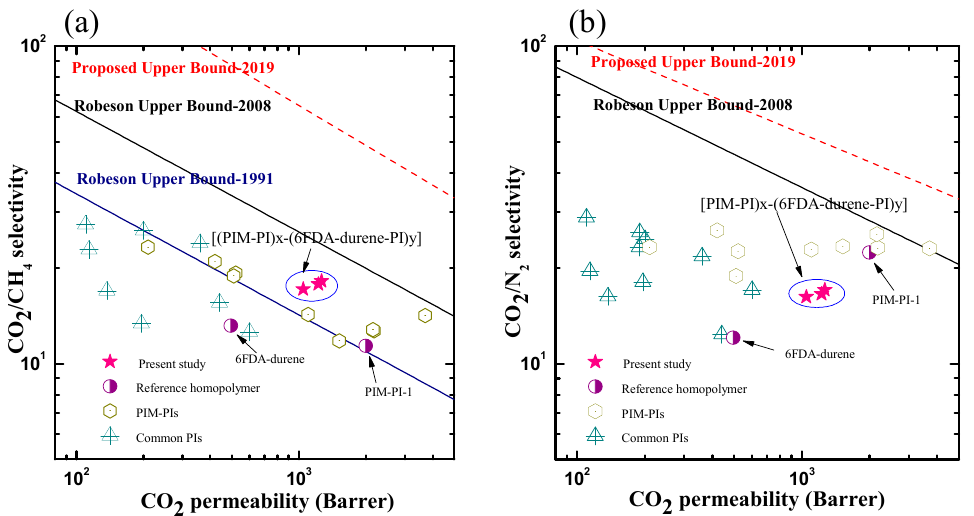
Figure 8. Robeson upper bound plots comparing the CO 2 /CH 4 ( a ) and CO 2 /N 2 ( b ) separation performance capabilities of the copolymer membranes with other reported PIM-PIs and common PIs; data taken from references [3–7,10,13,15,17,23–25,33].